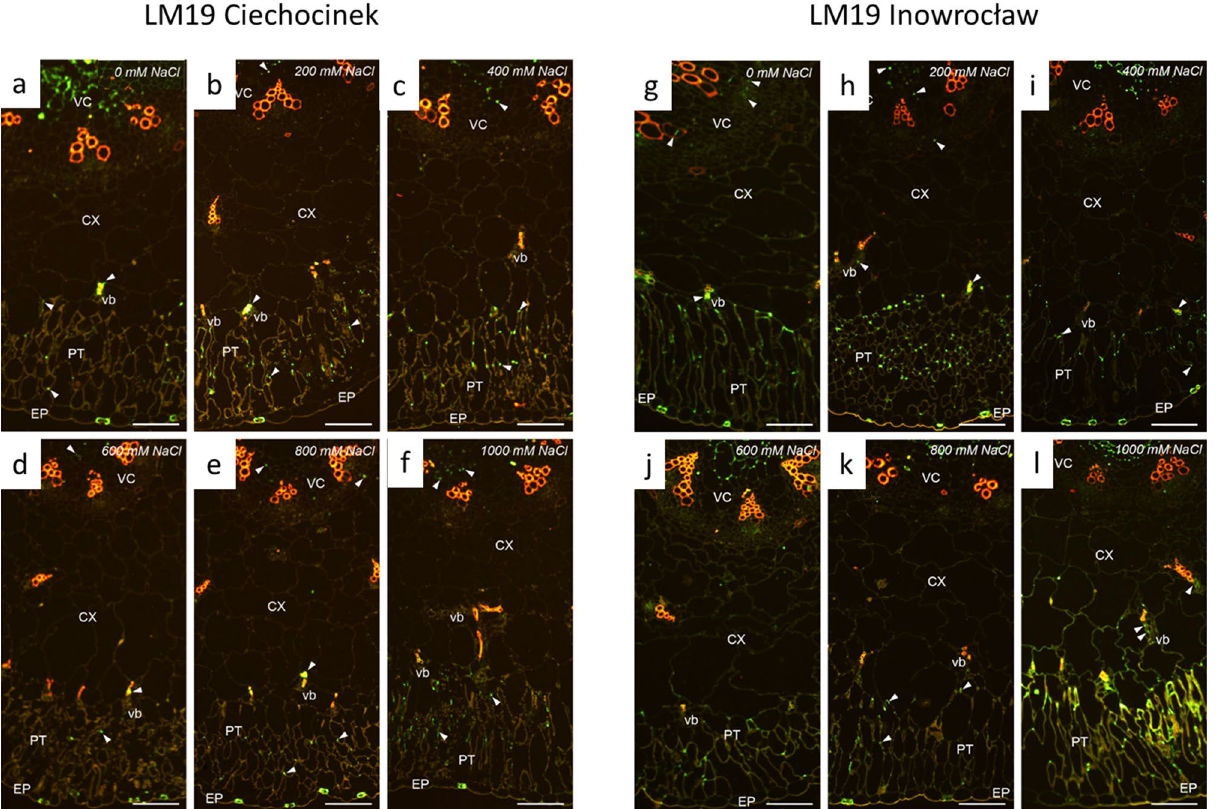
Figure 6. Immunofluorescence location (arrowheads) of low methylesterified homogalacturonans (LM-HGs) under NaCl stress for two S. europaea populations. ( a – f ) Ciechocinek and ( g – l ) Inowrocław. EP epidermis, PT